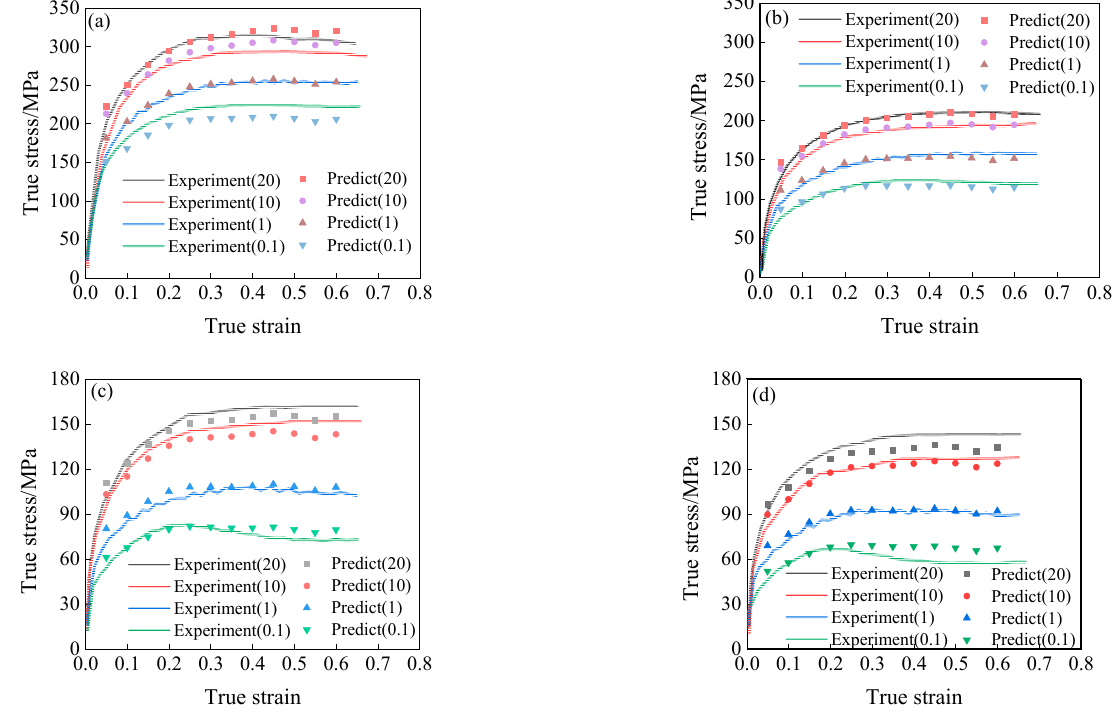
Figure 10. The predicted results of flow stress, ( a ) T = 1073 K; ( b ) T = 1223 K; ( c ) T = 1323 K; ( d ) T = 1373 K.